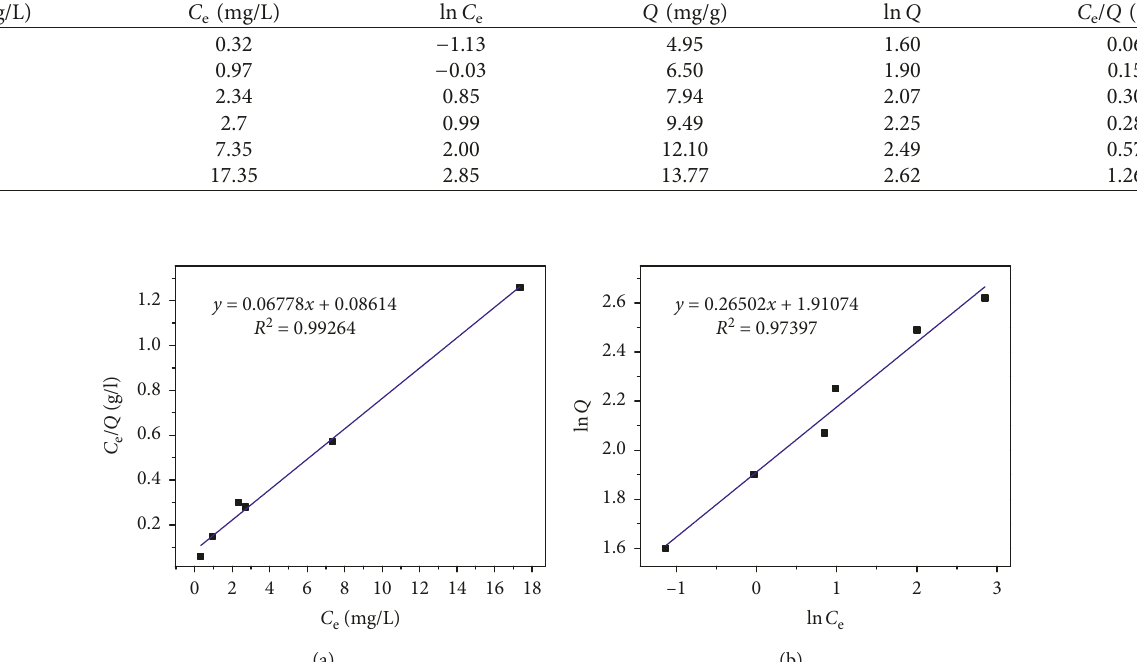
Table 4: The values of ln C e , ln Q , and C e / Q ratio determined from the different initial concentrations of Pb C 0 (mg/L)